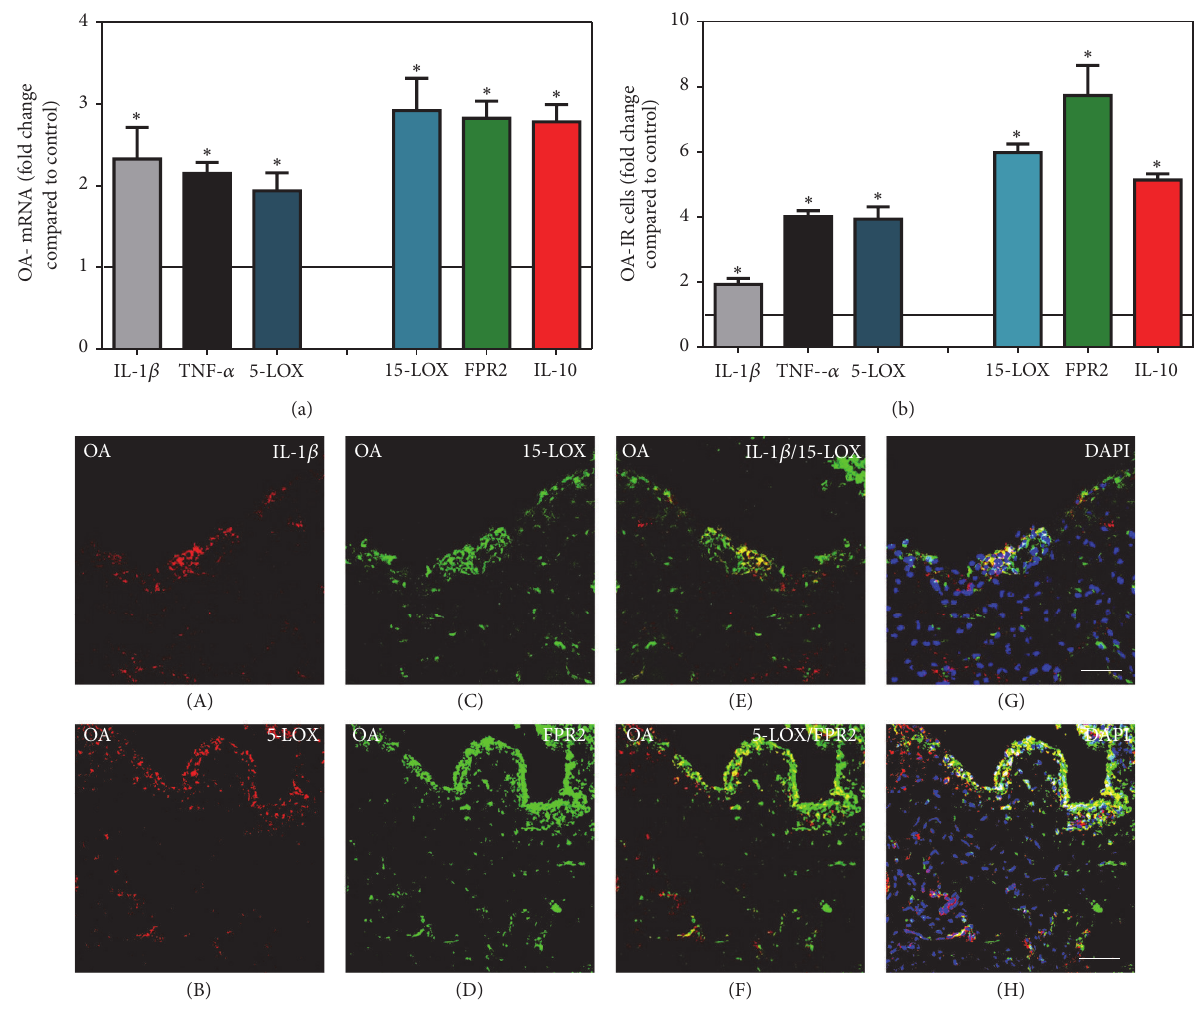
Figure 6: Detection of mRNA (a) and the number of positive cells of pro- (IL-1 𝛽 , TNF- 𝛼 , and 5-LOX) versus anti-inflammatory (15- LOX, FPR2, and IL-10) mediators (b and c) in patients with osteoarthritis (OA). Quantification of mRNA of pro- versus anti-inflammatory mediators shows that anti-inflammatory mediator expression was more prominent than inflammatory mediators in OA synovium. ∗ Relative to control ( 𝑃 < 0.05 , one-way ANOVA followed by Tukey’s test). (b) Quantitative analysis of immunofluorescent microscopy pro- versus anti- inflammatory mediators shows that the number of cells expressing anti-inflammatory mediators was more prominent than those containing proinflammatory mediators in OA synovium; the asterisks denote significant differences ( 𝑃 < 0.05 , one-way ANOVA followed by Dunn’s test). Data are shown as means ± SEM. (c) Confocal microscopy of pro- ( red fluorescence ; (A) and (B)) and anti-inflammatory mediators ( green fluorescence ; (C) and (D)) double immunofluorescence in OA synovium. Note that anti-inflammatory mediator expression was more prominent than proinflammatory mediators in OA synovium. Bar = 40 𝜇